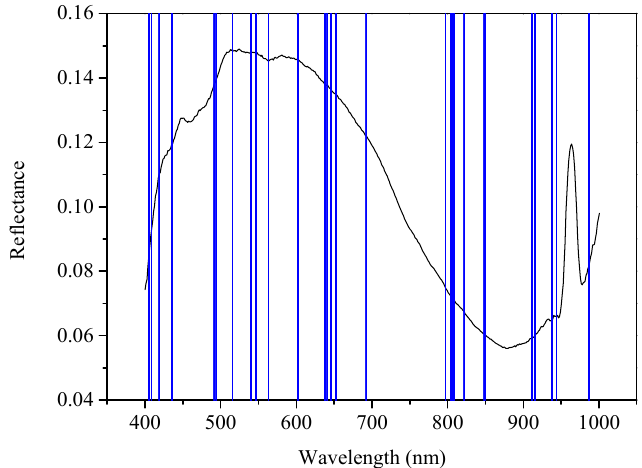
Table 4. Confusion matrix of training set for CARS-GOA-SVM simplified model.